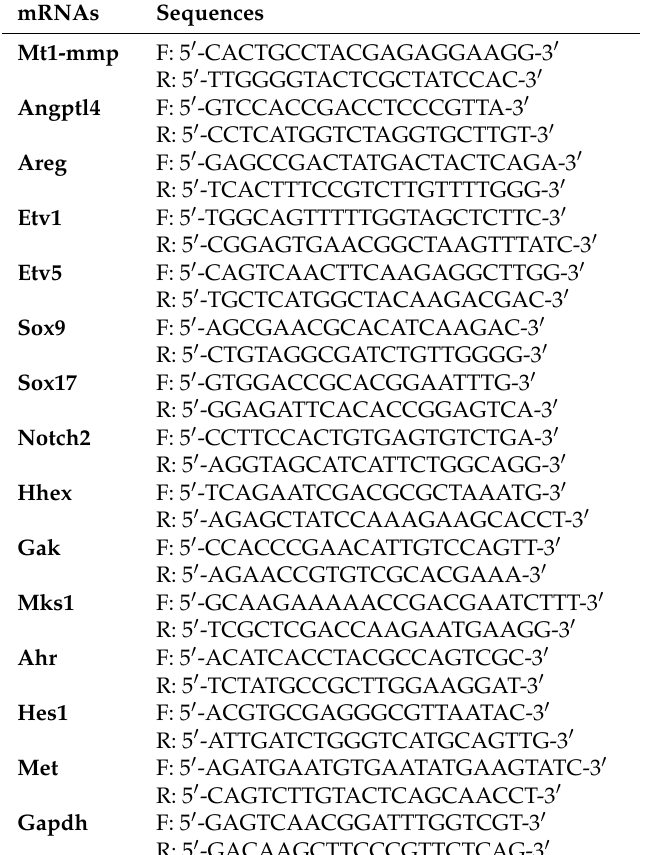
Table 1. Primers used for